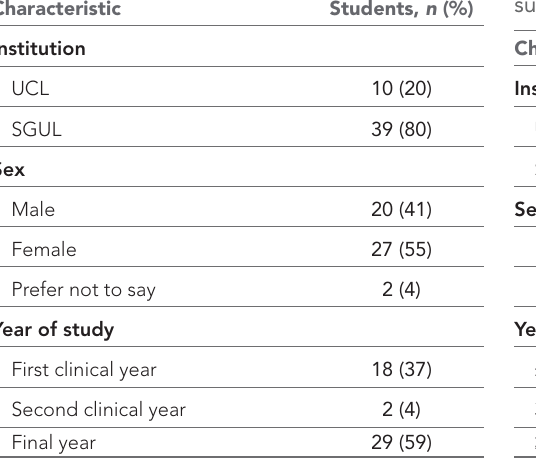
Table 2 Characteristics of the tutor